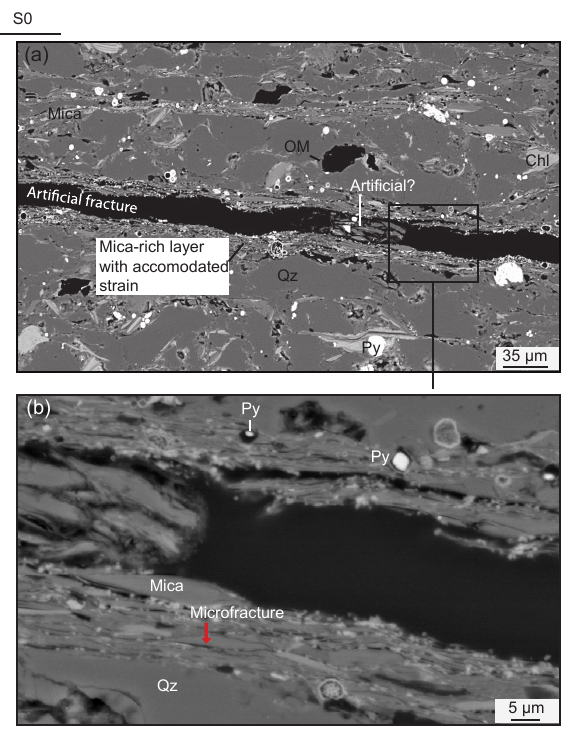
Figure 8. Fracture porosity. (a) Coarse-grained quartz-rich layers intercalated with fine-grained sheet-silicate-rich layers in sample F. (b) Strain accommodated in fine-grained sheet-silicate-rich layers by alignment of sheet silicates and the formation of